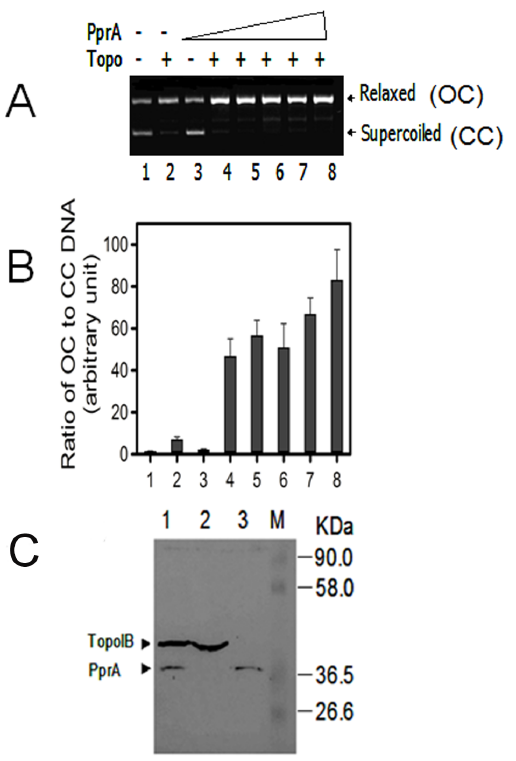
Figure 4. Effect of purified PprA on D. radiodurans Type IB topoisomerase activity. Plasmid DNA having both supercoiled (CC) and relaxed (OC) species was incubated with purified recombinant DraTopoIB (Topo) alone and with increasing molar ratio (1, 2, 3, 4 and 5) of purified PprA. Products were analysed on 1% agarose gels (A). Supercoiled (CC) and relaxed (OC) DNA band intensities were quantified and the ratios of OC to CC were plotted (B). In (C), cell free extracts of E. coli expressing PprA and DraTopoIB from pETpprA and pETtopoIB plasmids respectively were immunoprecipitated with anti PprA antibodies (1). This immunoprecipitate and extracts of cells expressing pETtopoIB (2) and pETpprA (3) independently were immunoblotted with antibodies against (His)6 tag and the sizes of these immunostained bands were compared to the molecular weight marker (M). DraTopoIB-His were immunoprecipitated with polyclonal anti- bodies against PprA, two protein bands with sizes corresponding to DraTopoIB and PprA were detected on immunoblots with monoclonal antibodies against the His tag (Figure 4C lane 1). Mixture of cell free extracts having both DraTopoIB and PprA proteins when processed without PprA antibodies did not yield immunosignals with (His)6 antibodies (data not shown)). Together,